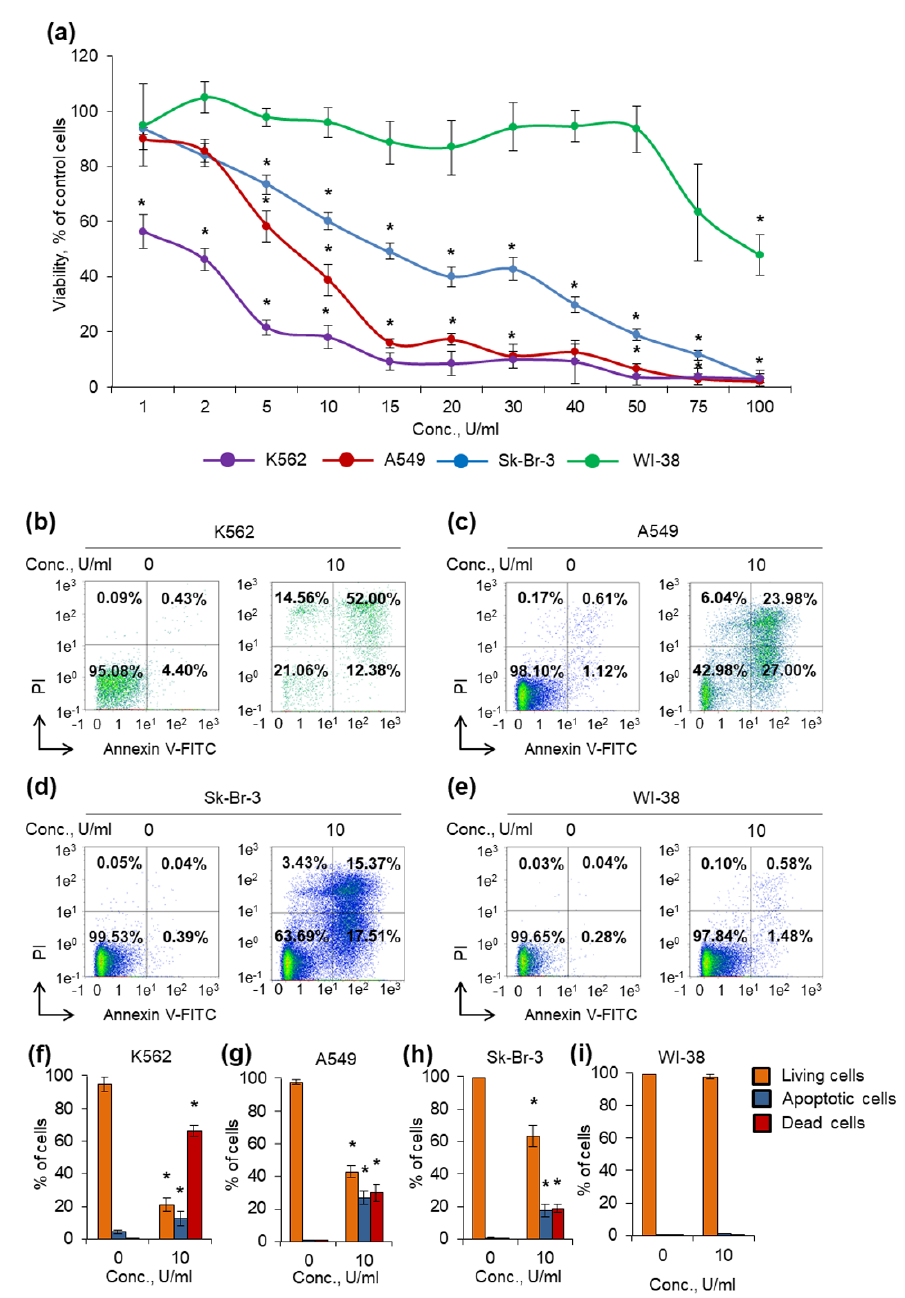
Figure 4. Cytotoxic activity of the enzyme against cancer cells. Cancer cells and normal fibroblasts were cultivated for 72 h in the presence of different concentrations of the enzyme. ( a ) Cell viability measured by MTT test. ( b – e ) Representative flow cytometry diagrams for cells incubated with 10 U/mL of the enzyme and labeled with annexin V-FITC and PI. Ratios of living cells (lower left quadrants), apoptotic cells (lower right quadrants) and dead cells (two upper quadrants) are presented. ( f – i ) Histograms of live, apoptotic and dead cells incubated with 10 U/mL of the enzyme. Conc., concentration. PI, propidium iodide. n = 4. * p ≤ 0.05 vs. control untreated cells.